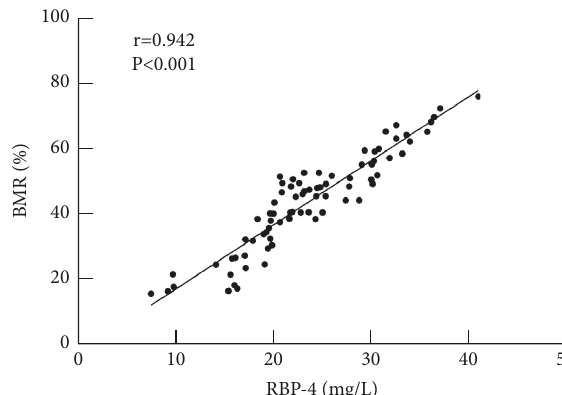
Figure 4: Scatter plot of correlation between theserum RBP-4 level and BMR in patients.